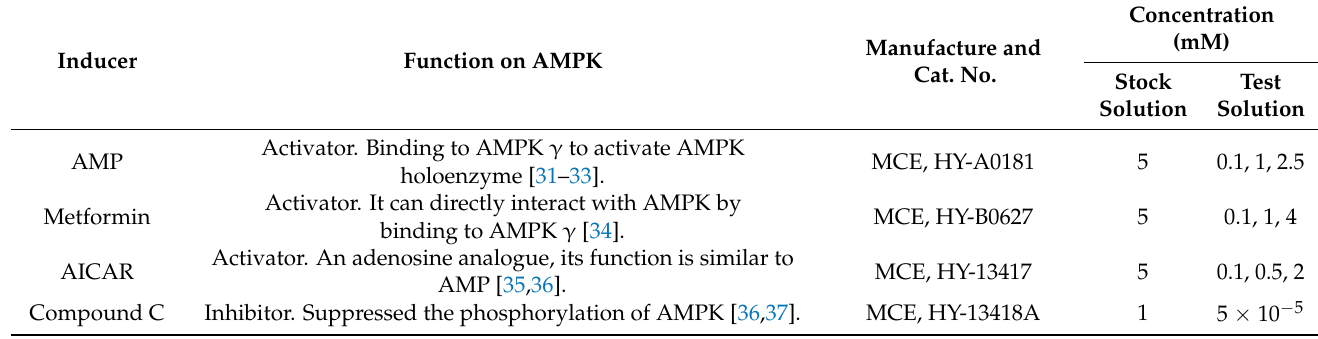
Table 2. Inducers used in the assay, and manufacturers and concentrations of stock and tested solutions.